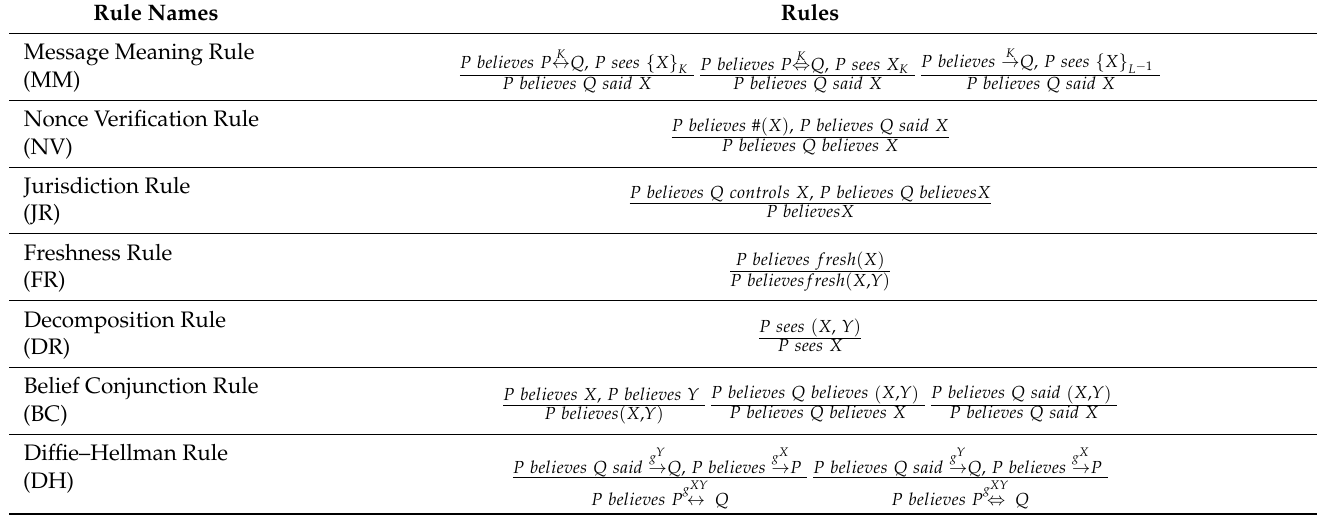
Table 3. BAN-Logic